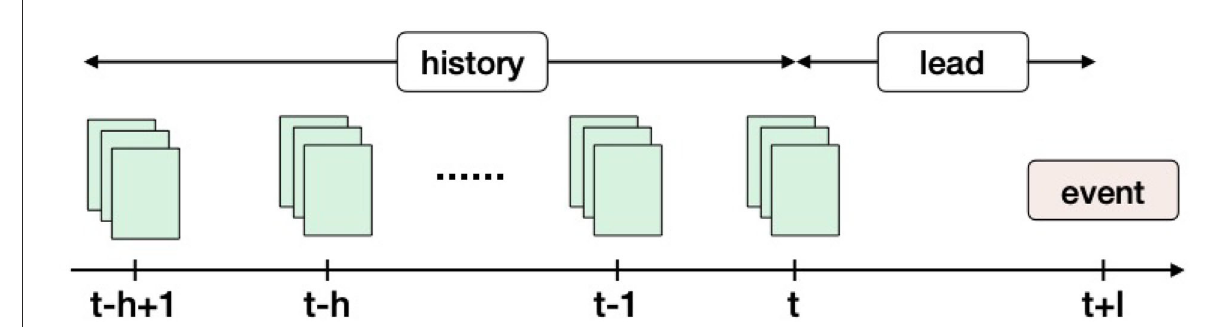
FIGURE2 Event precursors identification overview. Here, h denotes the number of timestamps in the event history and l is the lead time. An event history could contain one or more external data sources (e.g., news articles, tweets, etc). The key idea in this framework is to anticipate an event at time